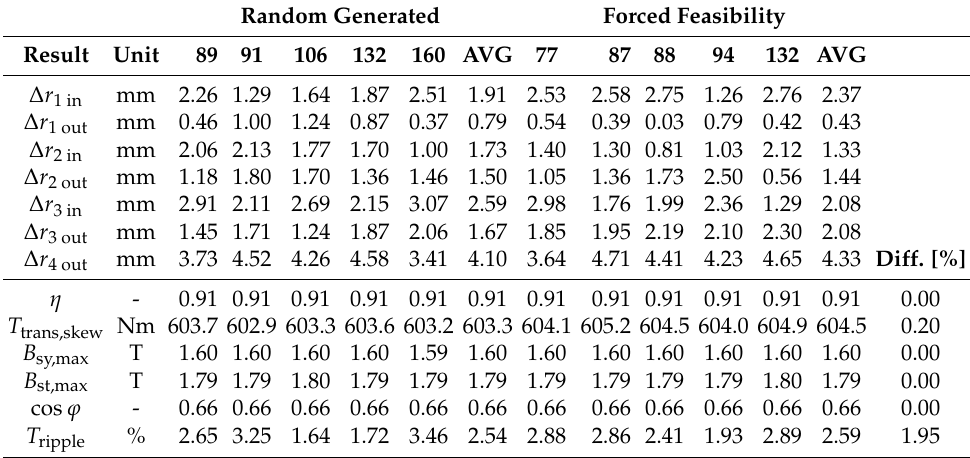
Table 4. Optimized rotor parameters and final result